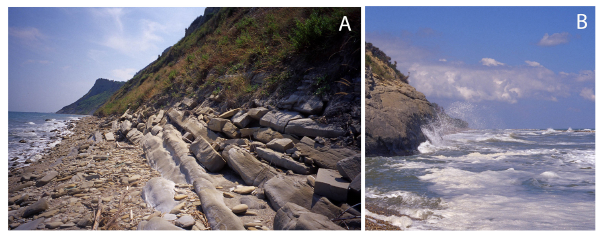
Figure 3. Two stretches of the San Bartolo cliff that show the peb- bly beach in the northernmost sector (A) and the substrate eroded by the storm waves in southernmost one